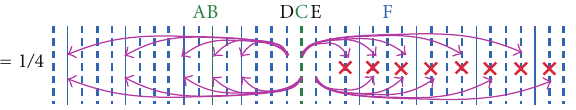
Figure 22: Electron configuration in excited state #2 at ν = 1 / 2.